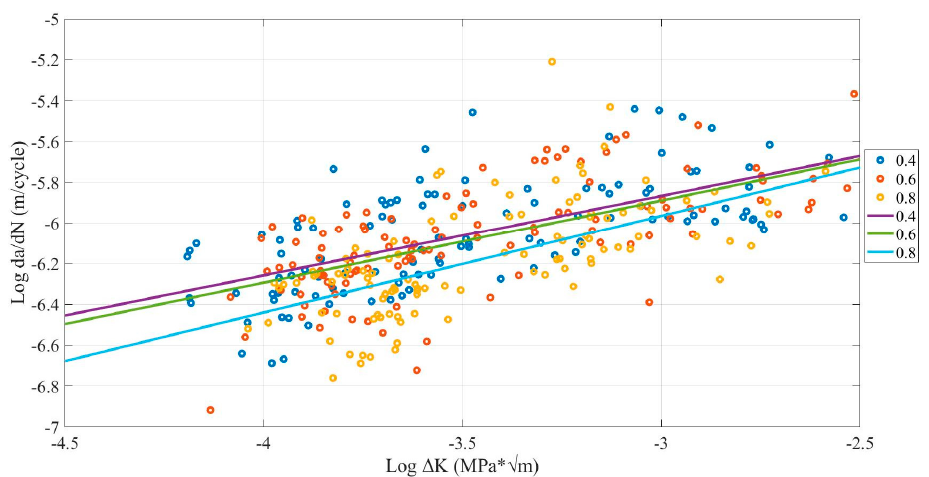
Figure 12. Comparison between nozzle size influence on FCG rate of FDM ABS samples with (0.05, 0.10 and 0.15 mm layer thickness and X, XY, Y building orientation) under 50, 60, 70 °C environmental temperatures. Table 7. The mean FCG rate and number of cycles of different nozzle sizes regardless of other print- ing parameters.